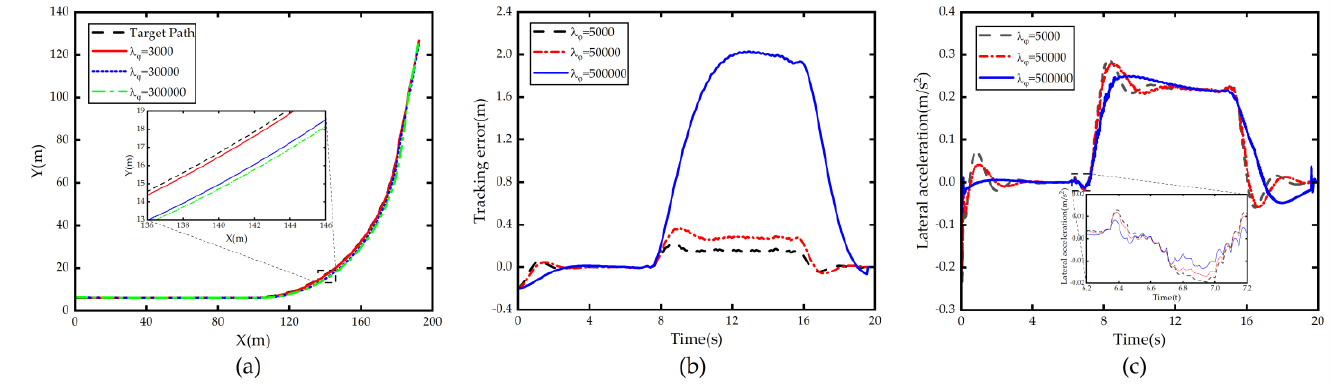
λ .( a ) Path; ( b ) Tracking error; ( c ) Lateral  .( a ) Path; ( b ) Tracking error; ( c ) Lateral 